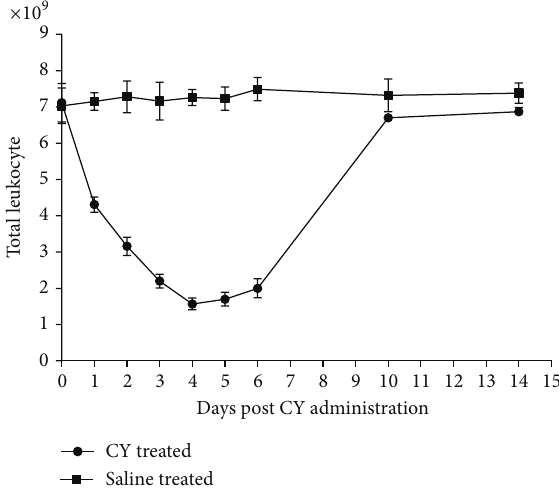
Figure 1: Total leukocyte counts. A time corresponding decrease was found in CY treated mice from days 1 to 4. The lowest data emerged at day 4 ( 𝑛 = 10 ).